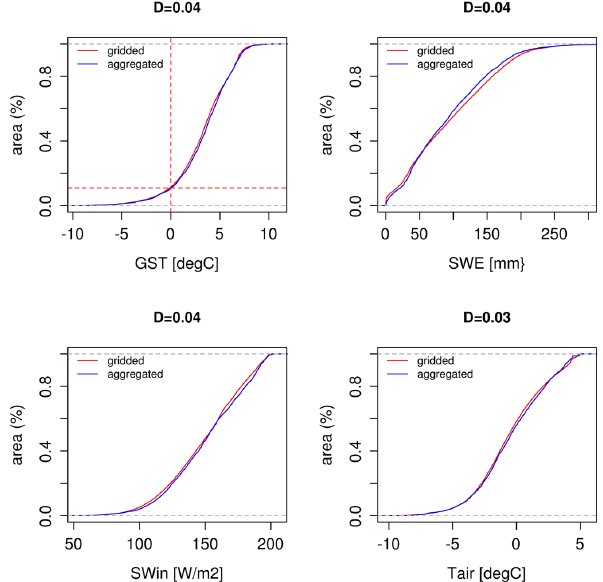
Fig. 8. CDFs of mean annual simulation results derived from the sub-grid scheme (blue) based on 258 samples and a distributed sim- ulation (red) based on 10 6 pixels. A good fit is reported by a KS-test ( D ). Aggregated summary statistics can be computed directly from the CDF, for example percentage area with MAGST < 0 ◦ C (red dotted line, top-left figure).